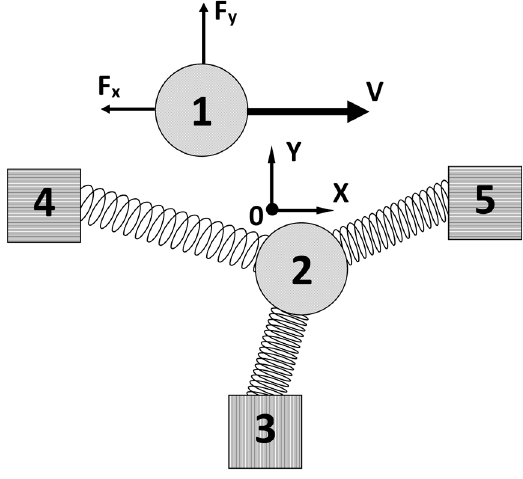
Figure 1. Atoms’ geometry of frictional pair in the pseudo-static 2D model: atom (1) of the slider and atom (2) of base elastically bonded to three rigid atoms (3,4,5).